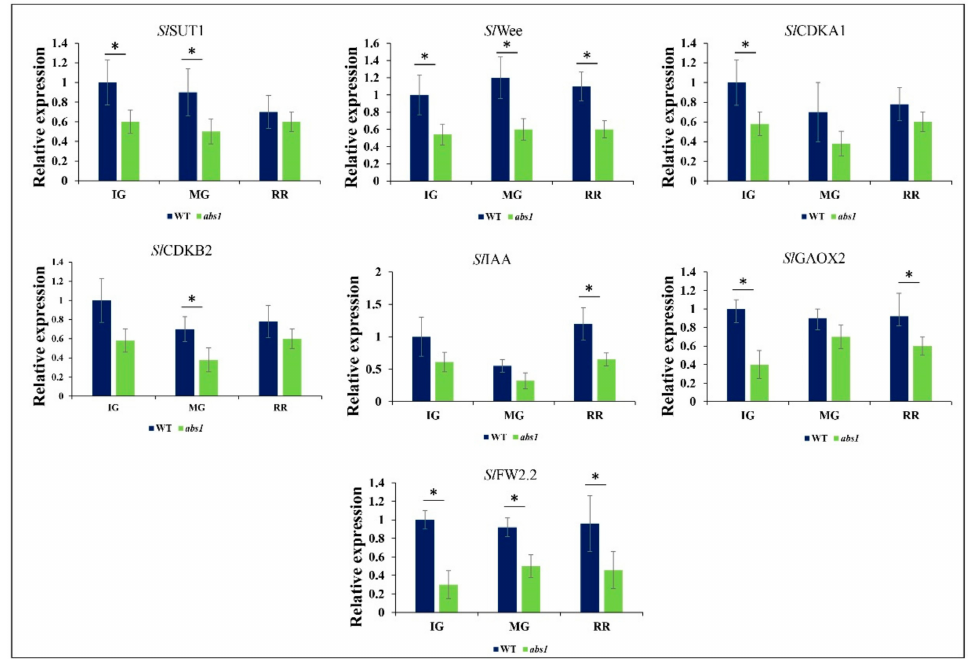
Figure 6. The relative expression of genes involved in cell expansion and cell division using qRT-PCR. The experiment was carried out using three biological and three technical replicates, and the values are presented as relative expression. The error bar represents the standard error. Asterisks indicate significant differences (*: p ≤ 0.05, Student’s t